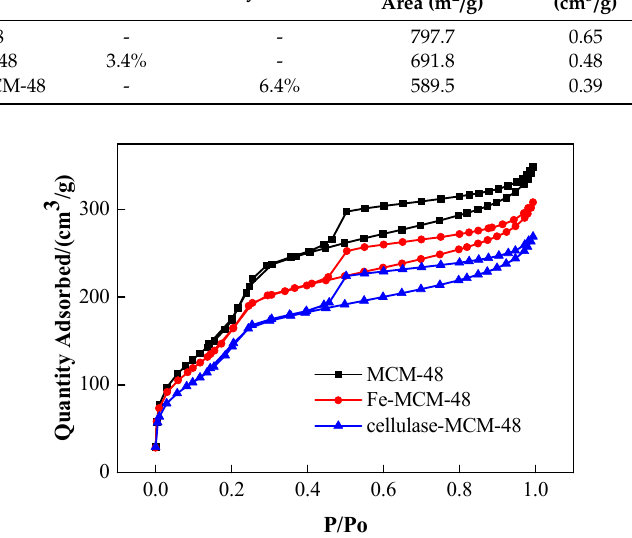
Figure 1. Adsorption–desorption isotherms of MCM-48 catalysts.